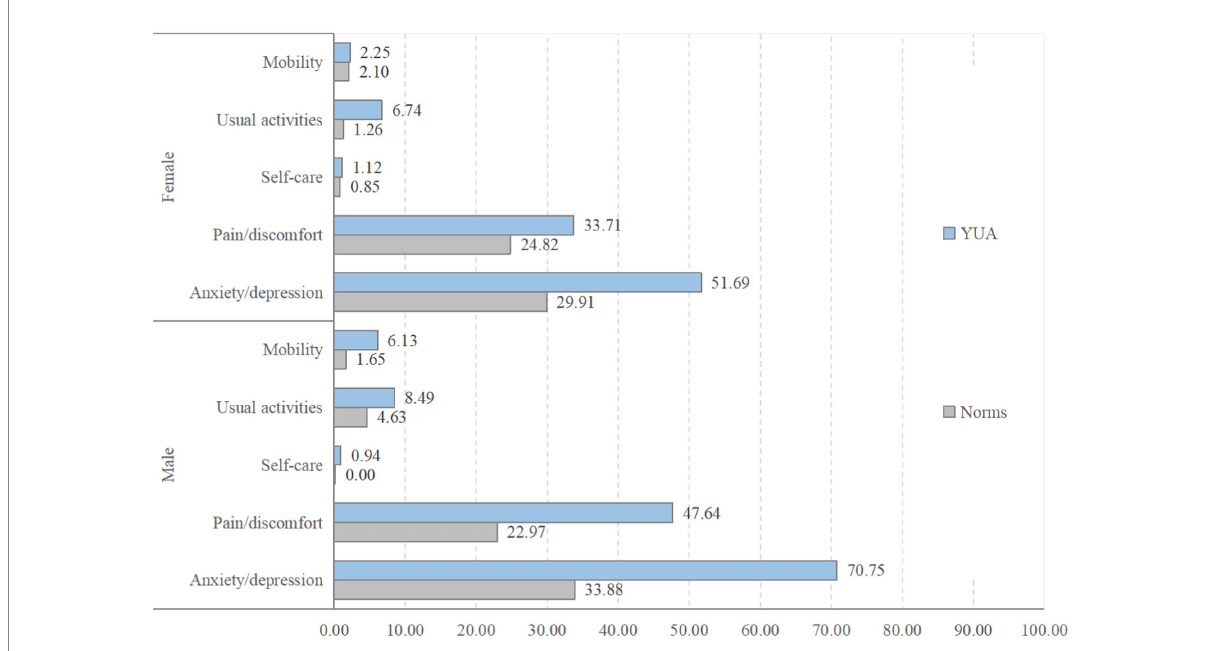
FIGURE 1 Percentages of respondents reporting health problems in comparison with population norms by gender. YUA – Young University Academics involved in this study. Data of population norms: Yang et al.